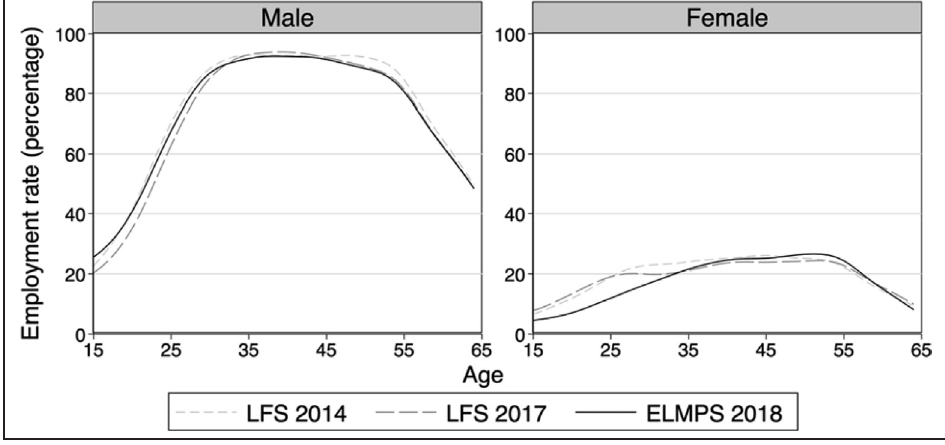
Source : Authors’ calculations from LFS 2014, 2017, and ELMPS